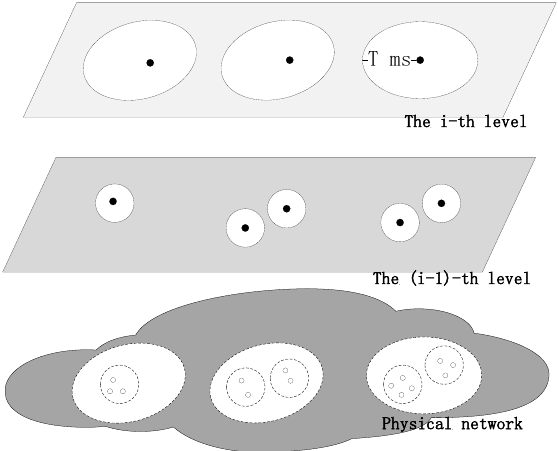
Figure 1. Enhanced name resolution